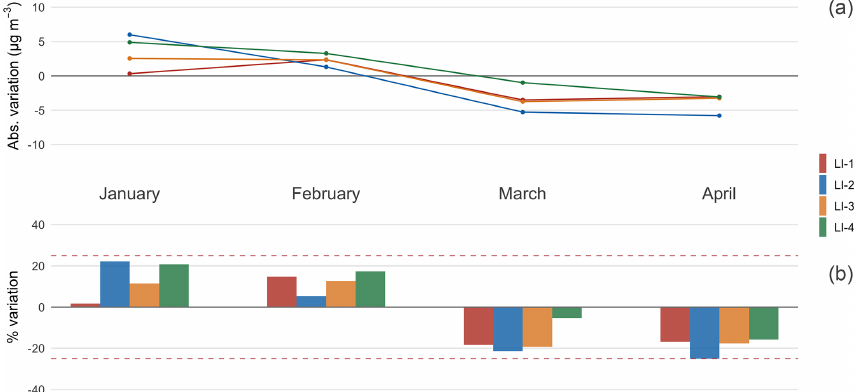
Figure 5. Livorno and coastal area: PM 10 (a) absolute variation and (b) percentage variation between monthly means of 2020 and 2017–